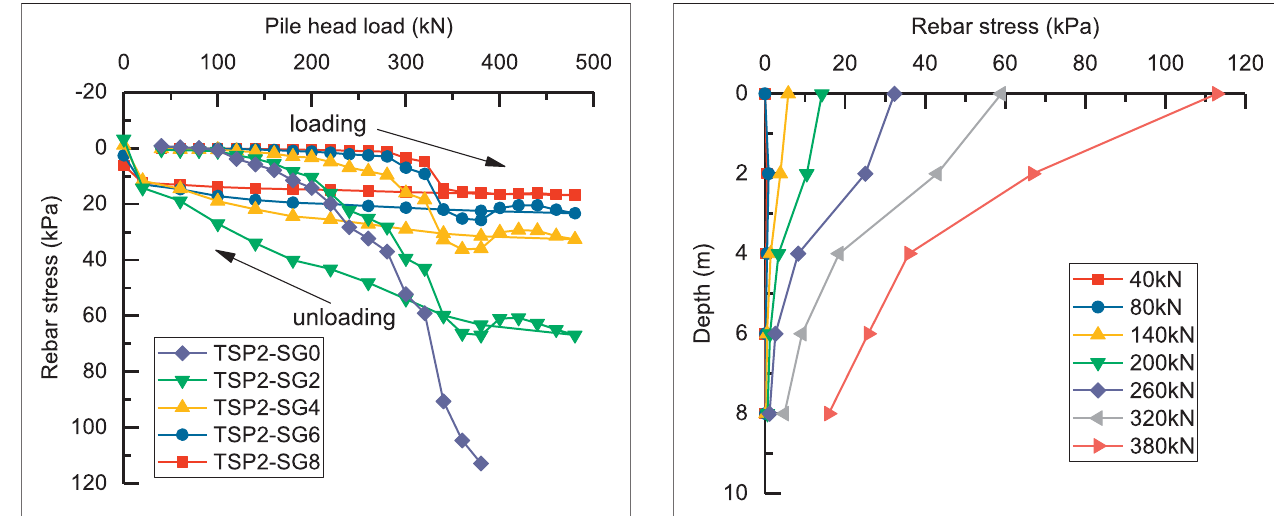
FIGURE 4 | Stress variation of TSP2 with depth under different loading stages.